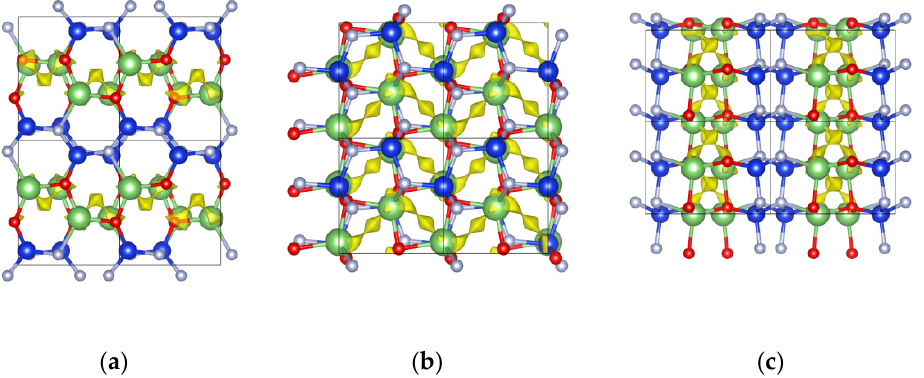
Figure 2. The Li + diffusion pathways evaluated using the bond valence method and represented by yellow isosurfaces, with the isovalue of 0.90 eV, viewed in the ( a ) ab -, ( b ) ac -, and ( c ) bc -plane. The green, blue, red, and gray spheres represent Li, Si, O, and N atoms, respectively.